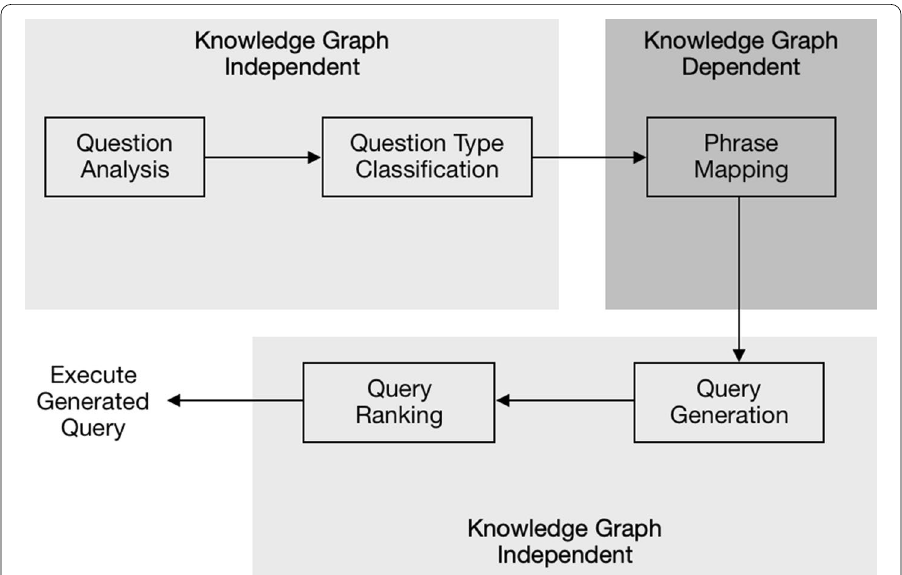
Fig. 1 The architecture of the proposed QA system includes five components for five different